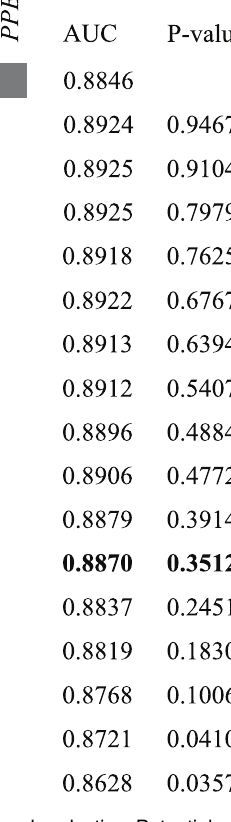
Fig 2. Stepwise backwards selection according to model number. Note. Logistic regressionmodelling with stepwisebackwardsselection.Potential predictor variablesare located in the top row. Model number is recorded in the left column. Area under the receiver operatingcurve (AUC) accordingto model number and the P-value accordingto the removedpredictor variable is located in the two rightward columns.